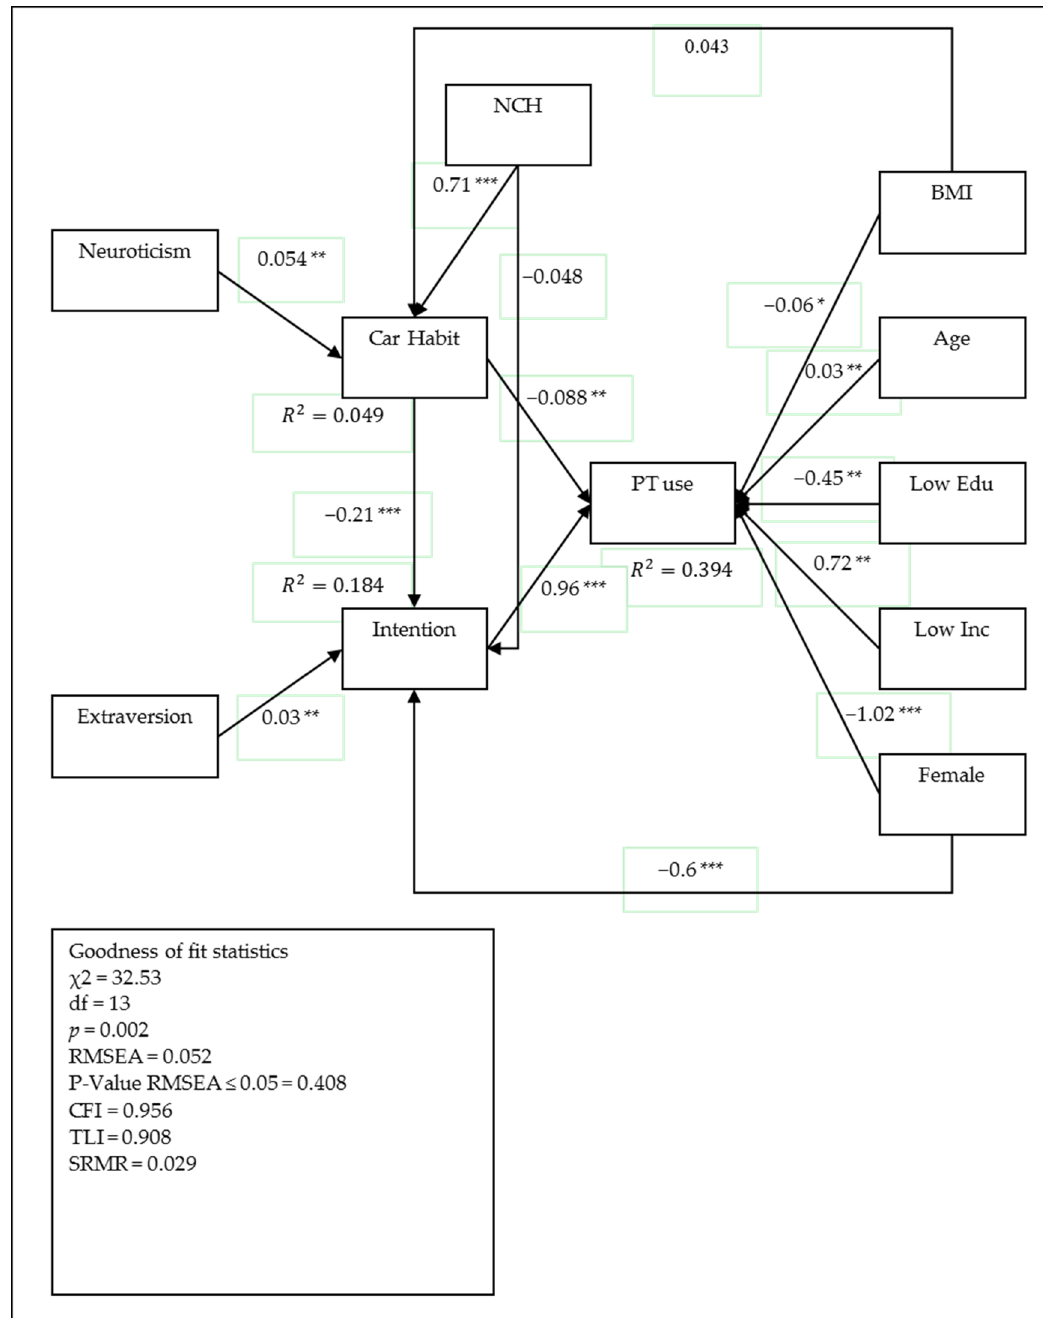
Figure 3. Results of the estimated SEM with the number of cars in household (NCH) variable effecting on car habit and intention toward public usage (* p ≤ 0.05; ** p ≤ 0.01; *** p ≤ 0.001), the sample size is equal to 557. Modified from proposed model. PT use: the number of future public transport usage.